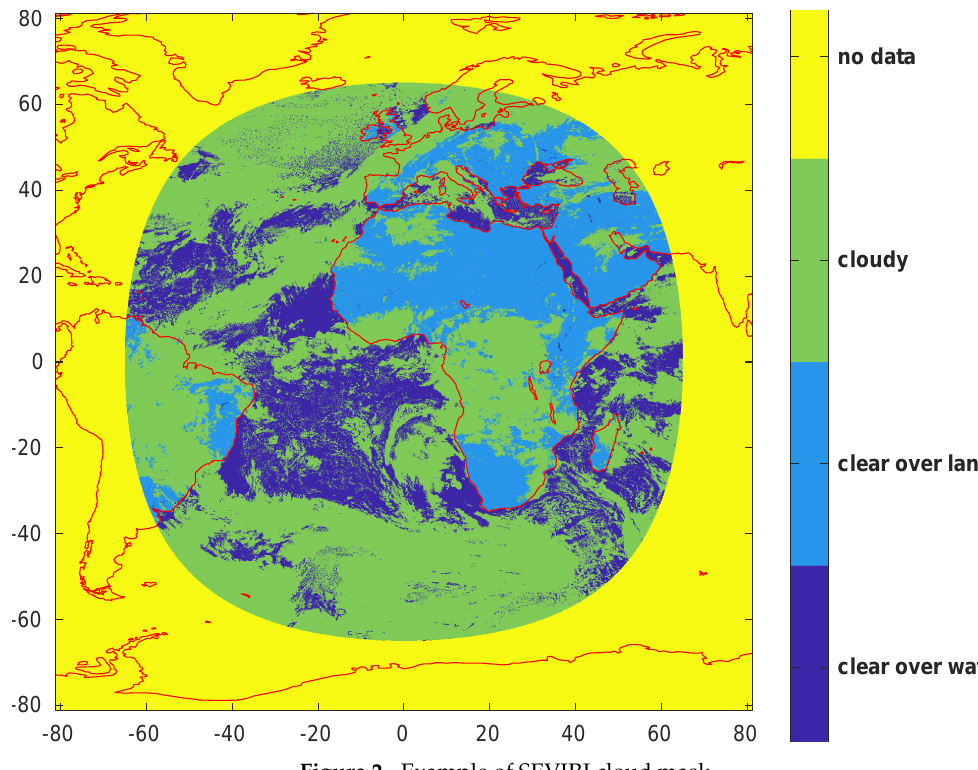
Figure 2. Example of SEVIRI cloud